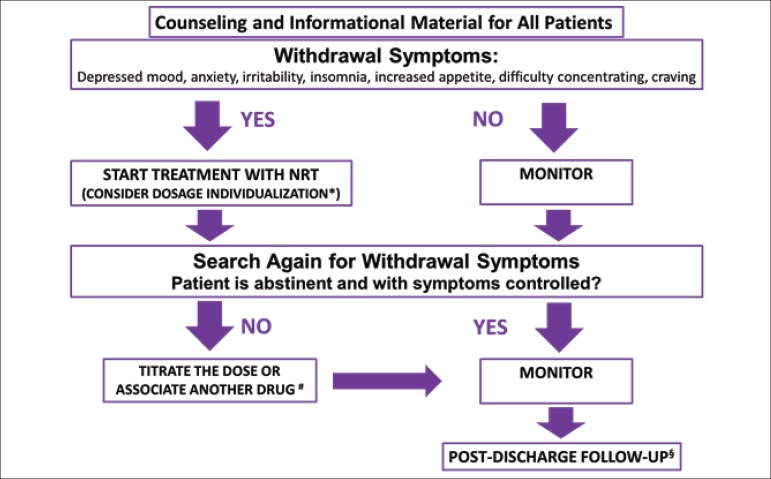
In-hospital patient algorithm.* < 20 CIGARETTES/DAY: 14 mg patches; 20-30 cigarettes/day: 21
mg patches; 31-40 cigarettes/day: 21 mg + 7 mg patches; > 40
cigarettes/day: 21 mg + 14 mg patches. For all cases, consider
the association with nicotine gum or tablet of 4 mg ad libitum.
† consider titration of transdermal nicotine dose (avoid
doses above 42 mg/day) or substitute for varenicline. ‡
outpatient return in a maximum of one month, with follow-up for
a time not lesser than one month. Reduce dose of NRT according
to the guidelines applicable to general situations.